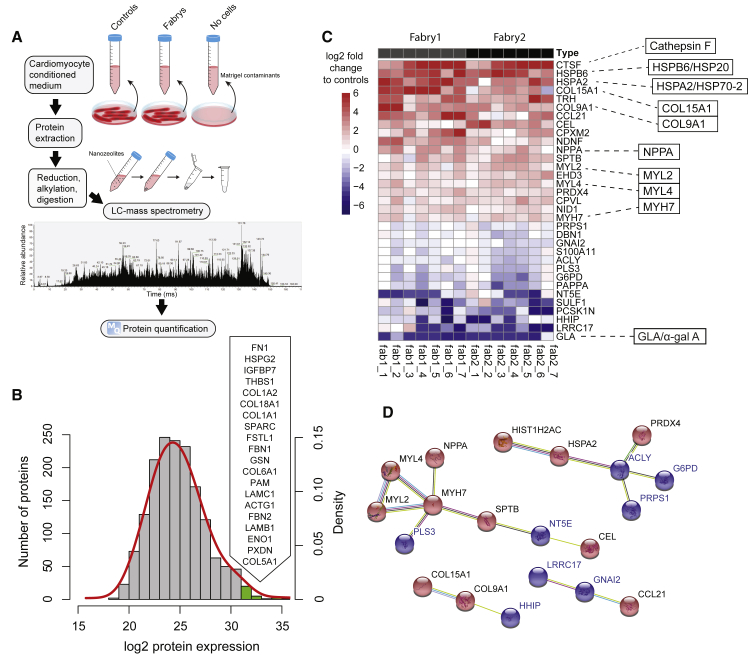
Secretome Analysis of Control and Fabry CMs(A) Schematic showing the workflow for protein isolation and secretome analysis using liquid chromatography-mass spectrometry from CM-conditioned medium.(B) Histogram showing the distribution of all detected proteins by their average expression level across all samples (control and Fabry). The red line shows the fitted normal density curve. The top 20 most highly expressed proteins (green bars) are listed in order.(C) Heatmap showing protein expression relative to controls in seven lysates from each Fabry line, from independent differentiations, of proteins >1 log2 fold changed up or down in both lines by average. Some particularly interesting candidates are highlighted to the right.(D) Results of STRING analysis showing potential protein-protein interactions, as run on the 34 differentially expressed proteins in Table S7. Up- and downregulated proteins in Fabry CMs are shown in red and blue, respectively.See also Figure S4.